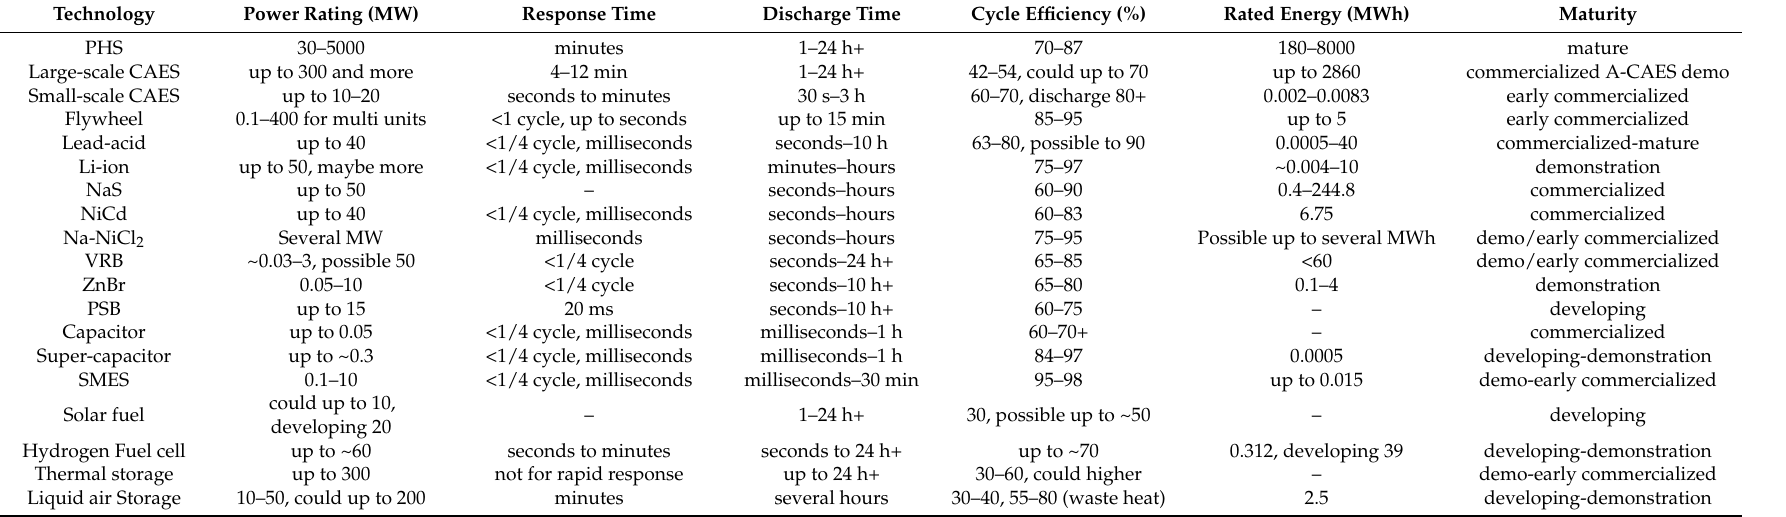
Table 8. Key technical characteristics of EES technologies for Grid Code realization